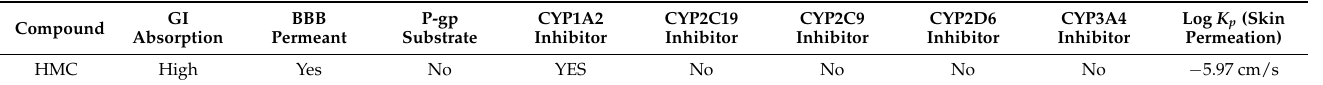
Table 5. Predicted pharmacokinetic properties of HMC.